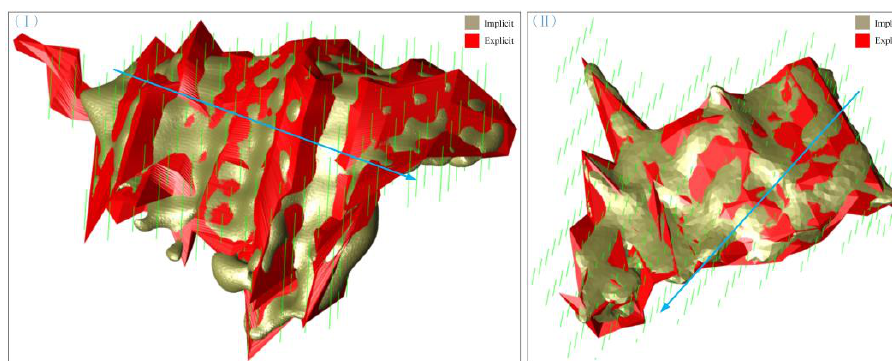
Figure 9. Explicit Model for Case I and Case II.